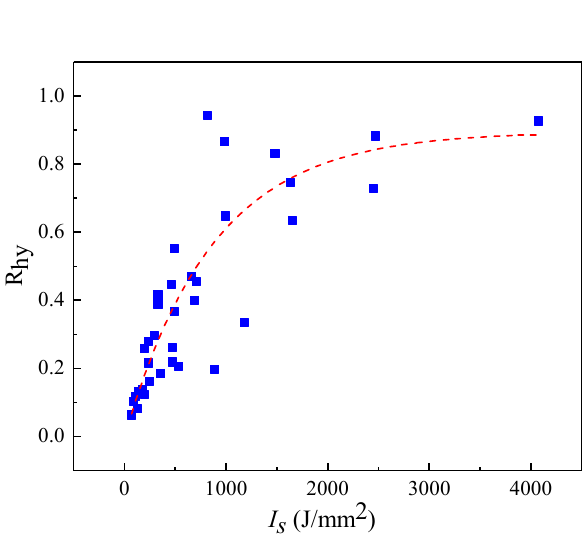
Figure 9. Scatter plots and fitted curve of R hy and I s .